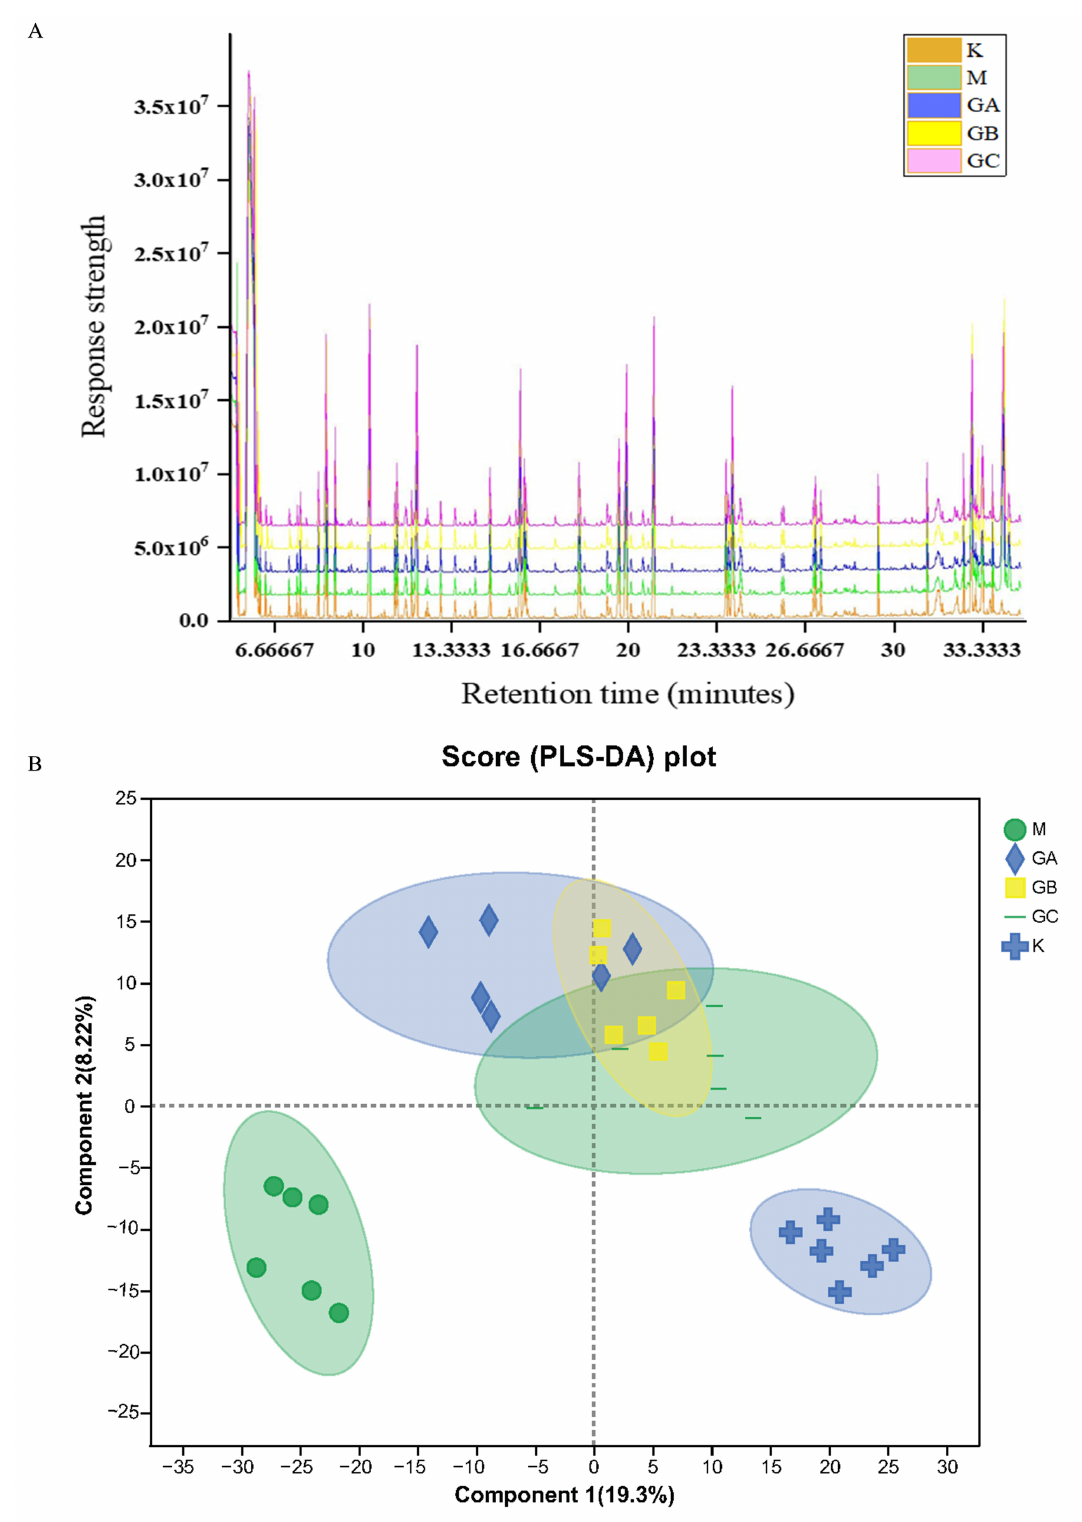
Figure 1. Effect of LYCRPLs on fecal metabolites in rats with a high-fat diet: ( A ) TIC overlay of QC samples; ( B ) PLS-DA results of fecal metabolites in different groups. Component 1 represents the interpretation degree of the first principal component and component 2 is the interpretation degree of the second principal component.